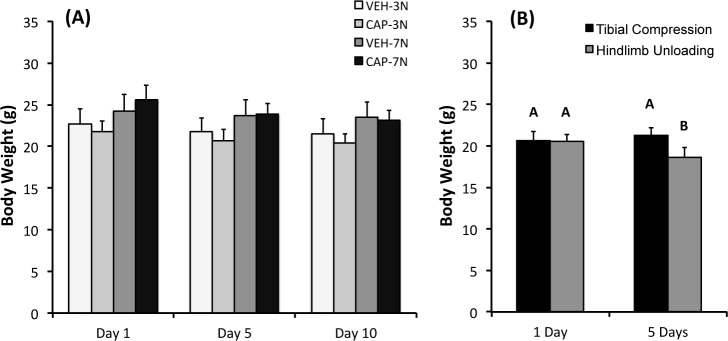
Body weights of mice during tibial compression or hindlimb unloading.(A) Body weights of capsaicin- and vehicle-treated mice subjected to tibial compression at 3 N or 7 N. (B) Body weights of mice subjected to 5 N tibial compression or hindlimb unloading. Groups not connected by the same letter are significantly different (p < 0.05).